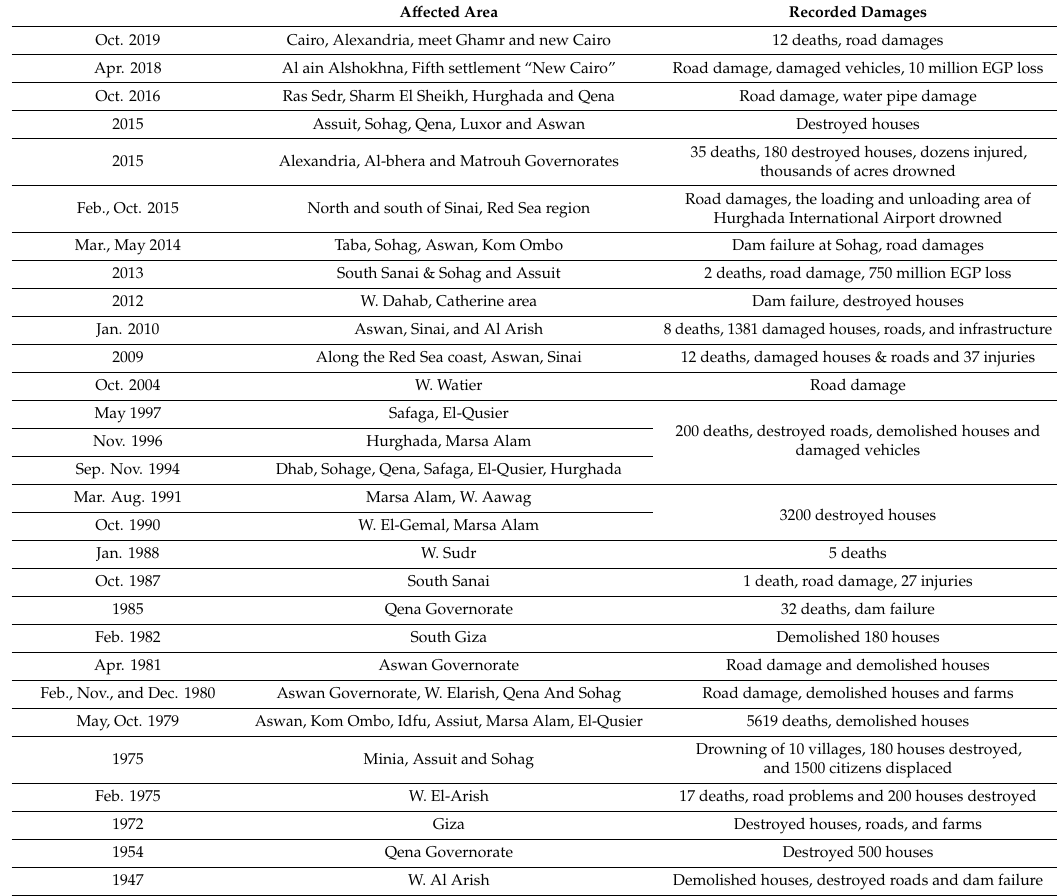
Table A1. Historical records of the hazardous flash floods in Egypt [1].